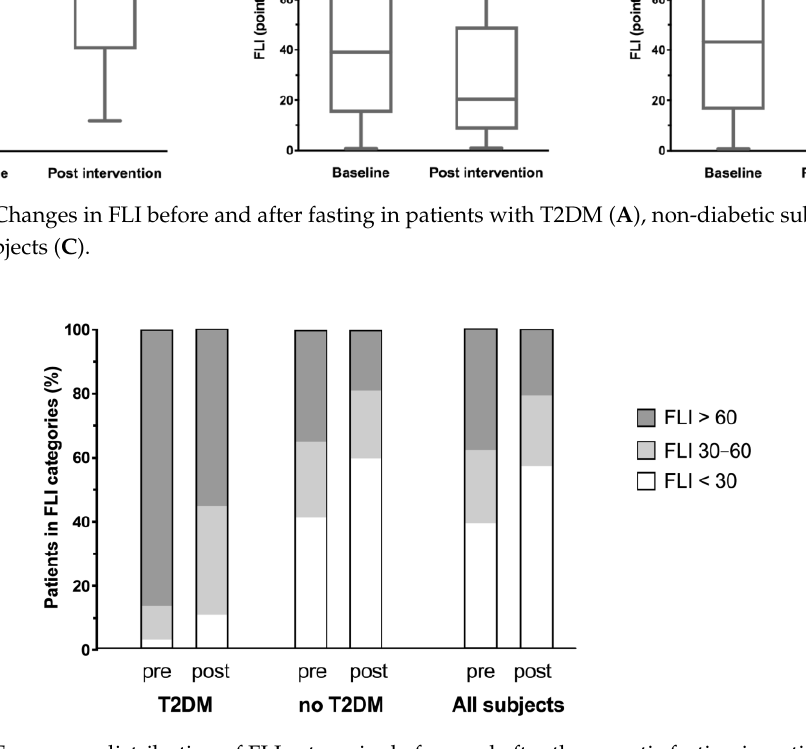
Table 2. Changes from baseline to post fasting, overall and for subjects with and without T2DM.